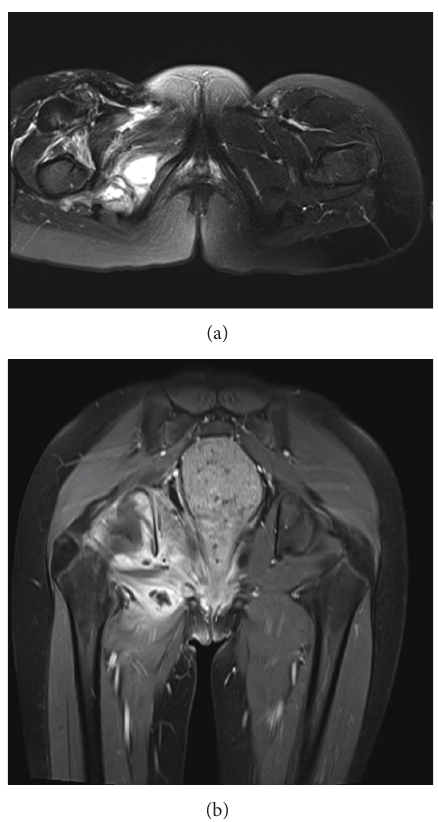
Figure 2: Axial T2-weighted (a) image, with fat saturation, showing right hip effusion and extensive myositis. A four weeks later (b) coronal T1 image with fat saturation, after gadolinium, showing increased signal intensity in the right femoral head, with erosions. There was associated edema of the surrounding tissues, hip effusion and myositis with